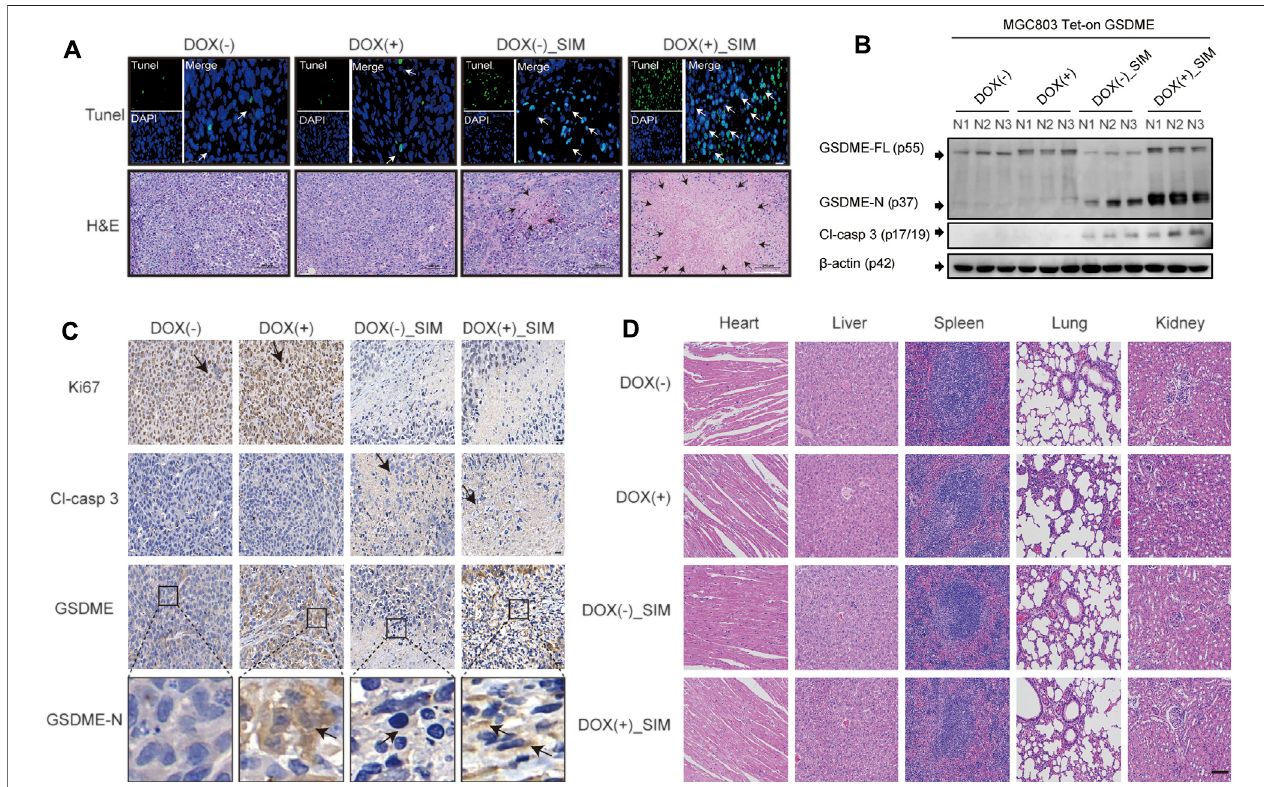
FIGURE5| SIMcombined withoverexpression-GSDMEpromotestheprogressionofGCpyroptosis invivo . (A) TUNELandH&Estainingimagesfortumourslices after indicated treatment. White arrows indicate TUNEL positive cells. TUNEL scale bar: 20 μ m; the areas of necrosis were indicated by black arrows in the fi gures. H&E scale bar: 100 µm. (B) Protein cleavage of GSDME and caspase-3 in tumour tissues, detected by Western blotting (C) Immunohistochemistry (IHC) images of Ki67, Cl- casp3,GSDME and GSDME-Nfortumourtissues after indicatedtreatment; blackarrowsindicate theIHC staining-positive cells; scale bar:20 µm. (D) HE staining of heart, liver, spleen, lung, and kidney tissues in each group; scale bar = 100